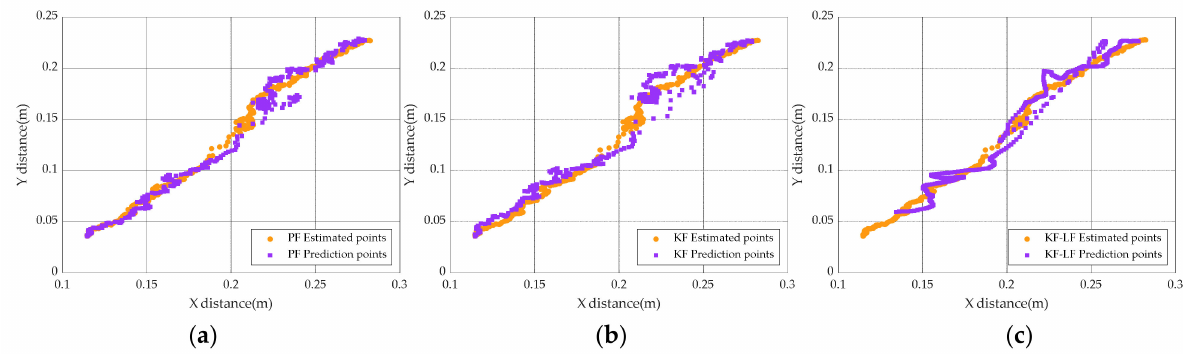
Figure 14. Comparison of the prediction effect of different filters under nonlinear conditions in the two-dimensional plane: ( a ) is the effect of PF in the two-dimensional plane; ( b ) is the effect of KF in the two-dimensional plane; ( c ) is the effect of KF-LF in the two-dimensional